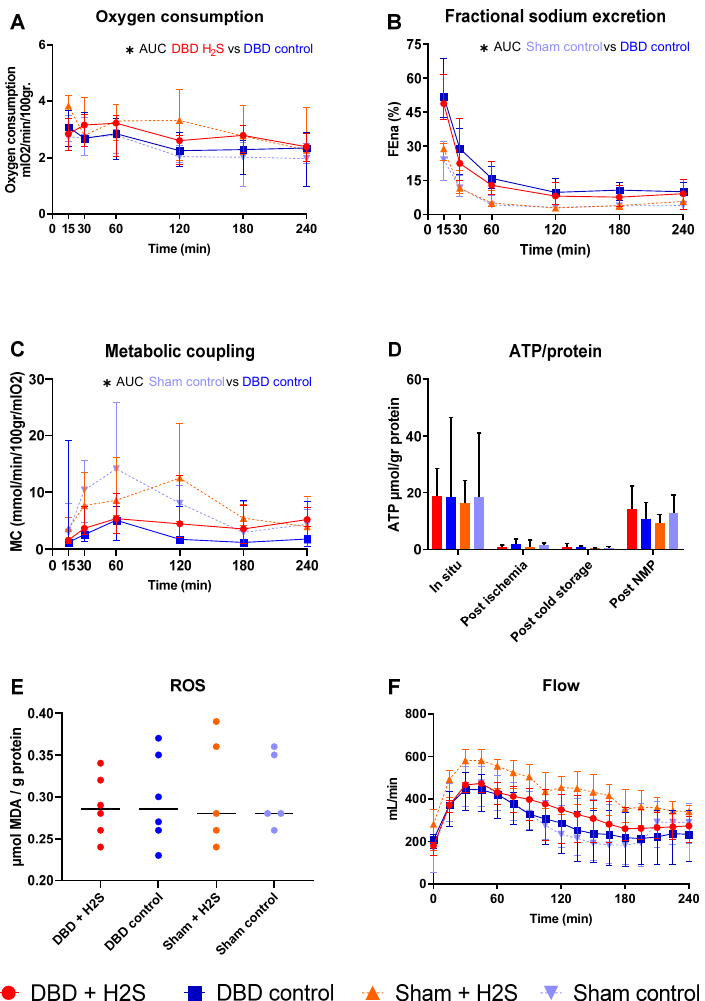
Figure 4. Metabolic activity and ROS. ( A ): Oxygen consumption (mlO 2 /min/100 gr). ( B ): Fractional sodium excretion (%). ( C ): Metabolic coupling (mmol/min/100 gr/mlO 2 ). ( D ): ATP values during preservation and after NMP (µmol/gr protein). ( E ): MDA after NMP, measured in tissue (µmol MDA/gram protein). ( F ): Arterial blood flow during NMP (ml/min). Data presented as median + interquartile range. * p < 0.05. Abbreviations: AUC = area under the curve. MDA = malondialdehyde.